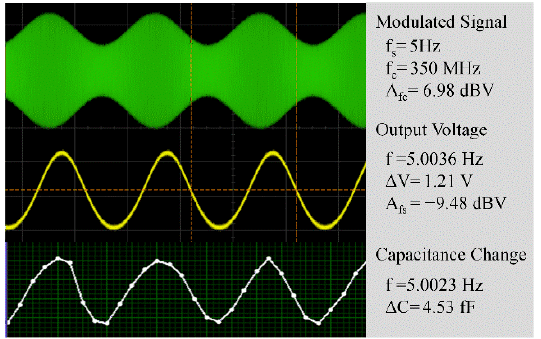
Figure 8. Cascaded MEMS ‐ based demodulation of an AM signal.